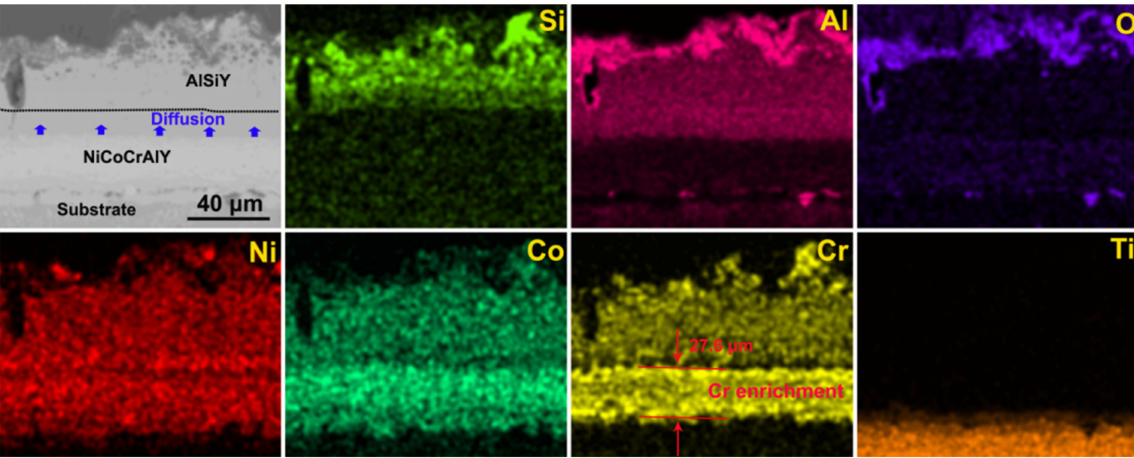
Figure 7. Cross-sectional images and element mappings of hot salt-water-corroded sample